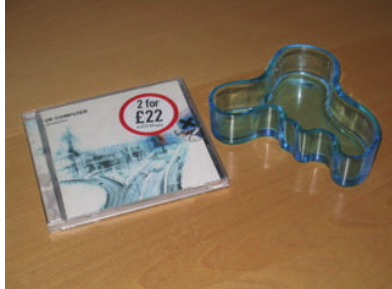
Figure 5: Objects used in the test.